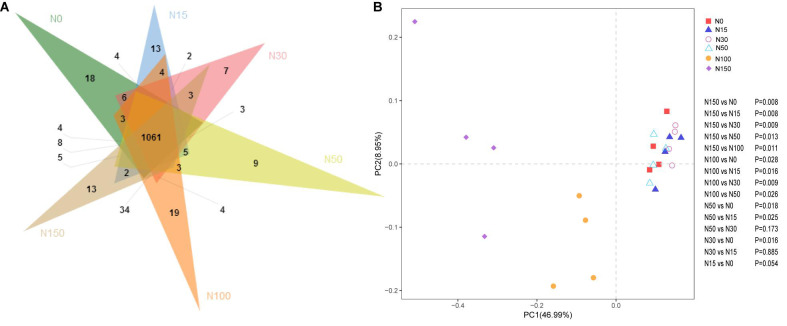
Effects of N addition on cbbL gene community composition. (A) Venn diagram of different N addition treatments. Different colors represent different N addition rates. The overlapping areas of the different colors represent the intersections (i.e., the common OTUs occur in areas where the color overlap, whereas the non-overlapping areas show unique OTUs). (B) Principal coordinate analysis (weighted PCoA) of cbbL gene communities based on Bray–Curtis dissimilarity matrices across different N addition treatments. Different shapes represent different N addition treatments. The percent variation explained by the plotted principal coordinates is indicated on the axes. Pairwise PERMANOVA results are displayed to the right of the PCoA. The cbbL-containing microbiota from the N100 (orange circles) and N150 (purple diamond) treatments clustered separately from cbbL-containing microbiota of the N0–N50 treatments (P < 0.05 by PERMANOVA).